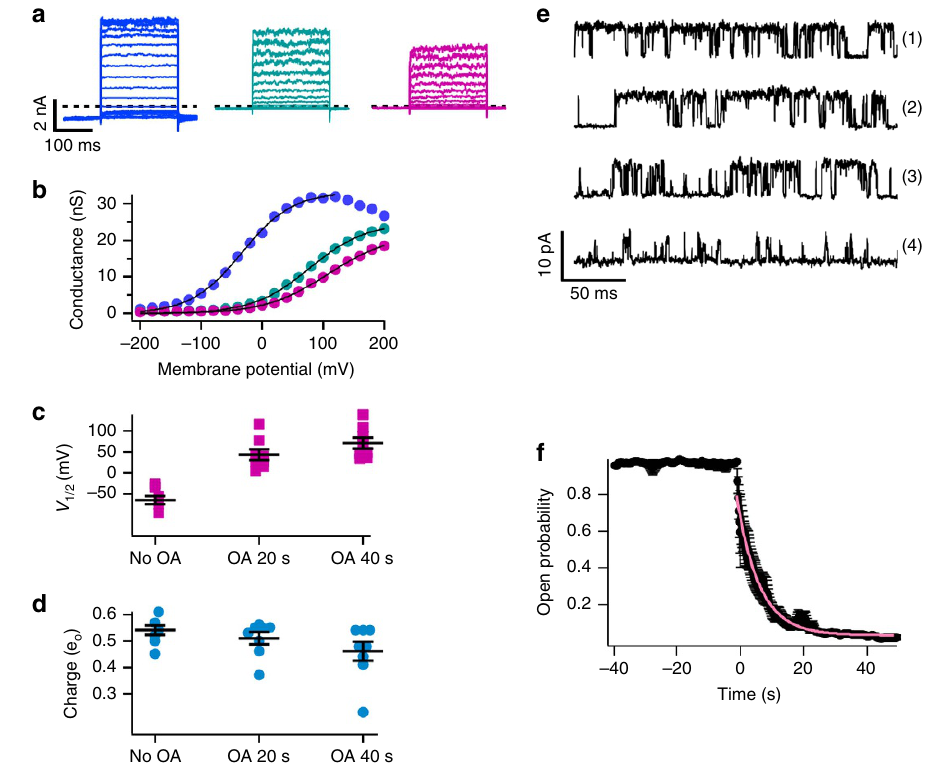
Figure 3 | Oleic acid inhibits rTRPV1 activation by voltage and capsaicin. ( a ) Currents activated by voltage (60mV) in the presence of 4 m M capsaicin (left), and after 20 (middle) and 40 (right)s of application of 5 m M OA. ( b ) The normalized conductance obtained from currents shown in a . In the absence of OA (no OA), blue; 20s after OA, turquoise; 40s after OA, pink. A fit to equation (1) (see Methods) is shown by the black curves. ( c ) The value of the voltage of half activation, V 1/2 , as a function of time after OA exposure, n ¼ 8 patches. For no OA ¼ (cid:2) 63 ± 9.2mV, 20s after OA ¼ 44 ± 12.9mV and 40s after OA ¼ 73.5 ± 13.4mV. ( d ) The value of the steepness of the Boltzmann fit, q a , as a function of time after OA exposure ( n ¼ 8 patches).